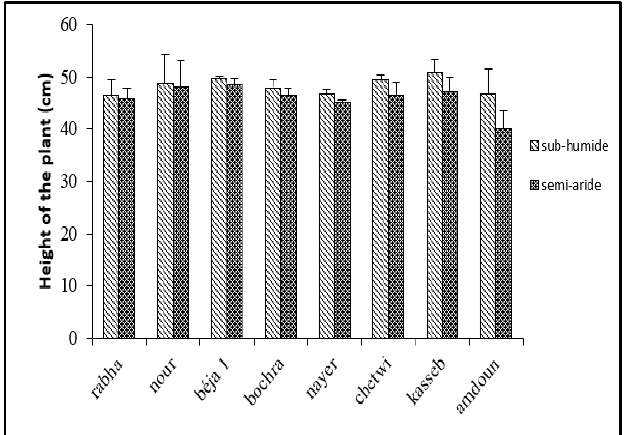
Figure 3: Mean values of the plant height as a function of the interaction’s varieties × bioclimatic stage